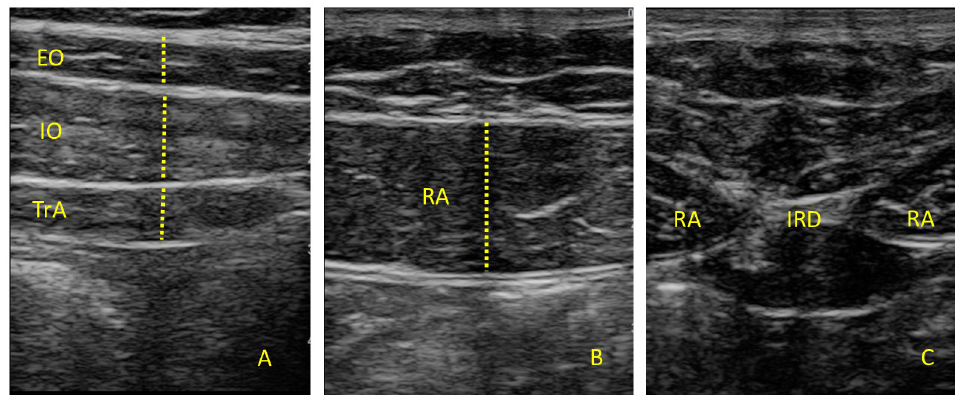
Fig 1. Ultrasonography of the abdominal wall muscles and IRD.